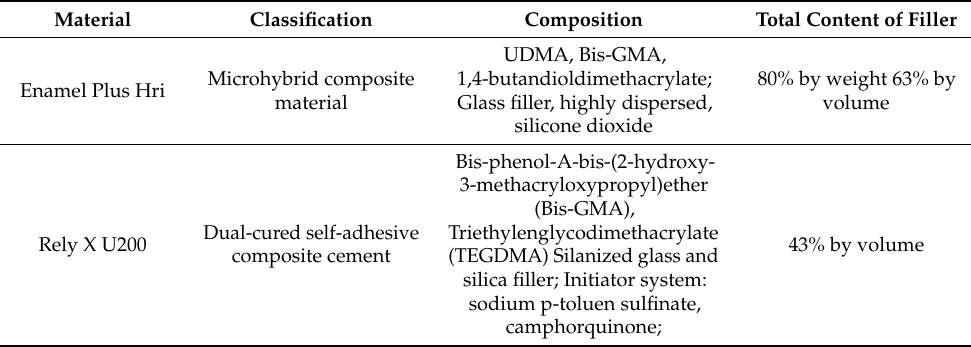
Table 1. Chemical composition of the tested